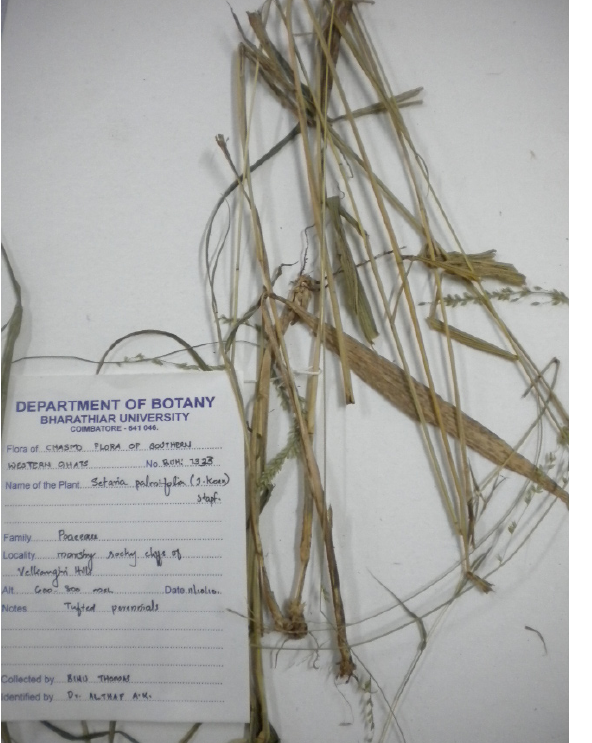
Image 31. Sorghum halepense (L.)